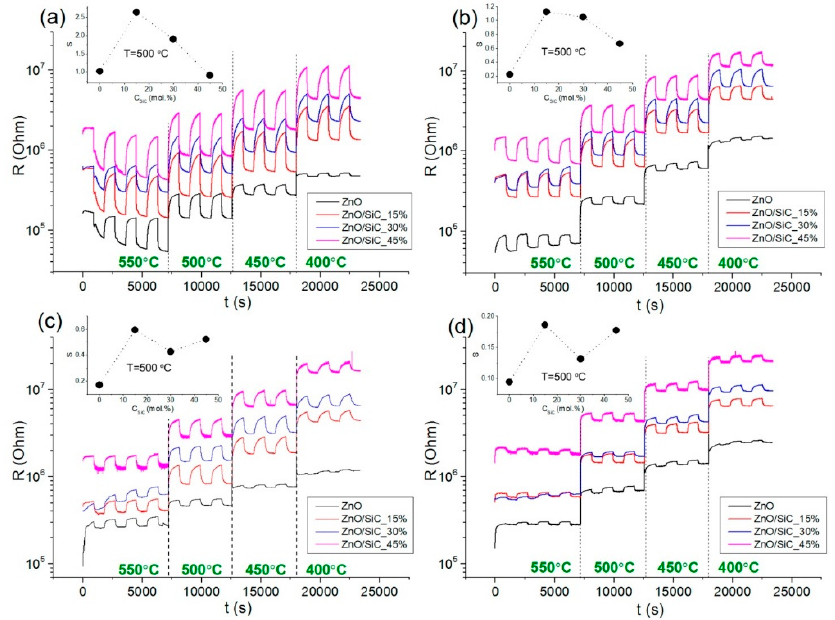
Figure 1. Change in the resistance of ZnO/SiC nanocomposites to 20 ppm NH 3 (a,b) and 20 ppm CO (c,d) in dry air (a,c) and at relative humidity RH 25 = 30%